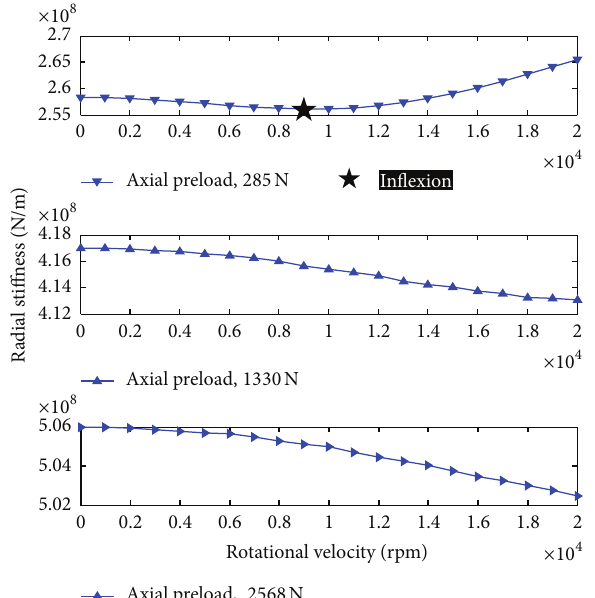
Figure 19: Radial operational stiffness of 70BNR10X bearing versus various preloads.